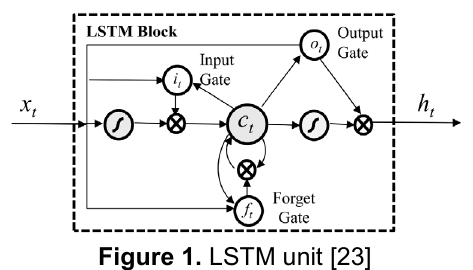
Figure 1. LSTM unit